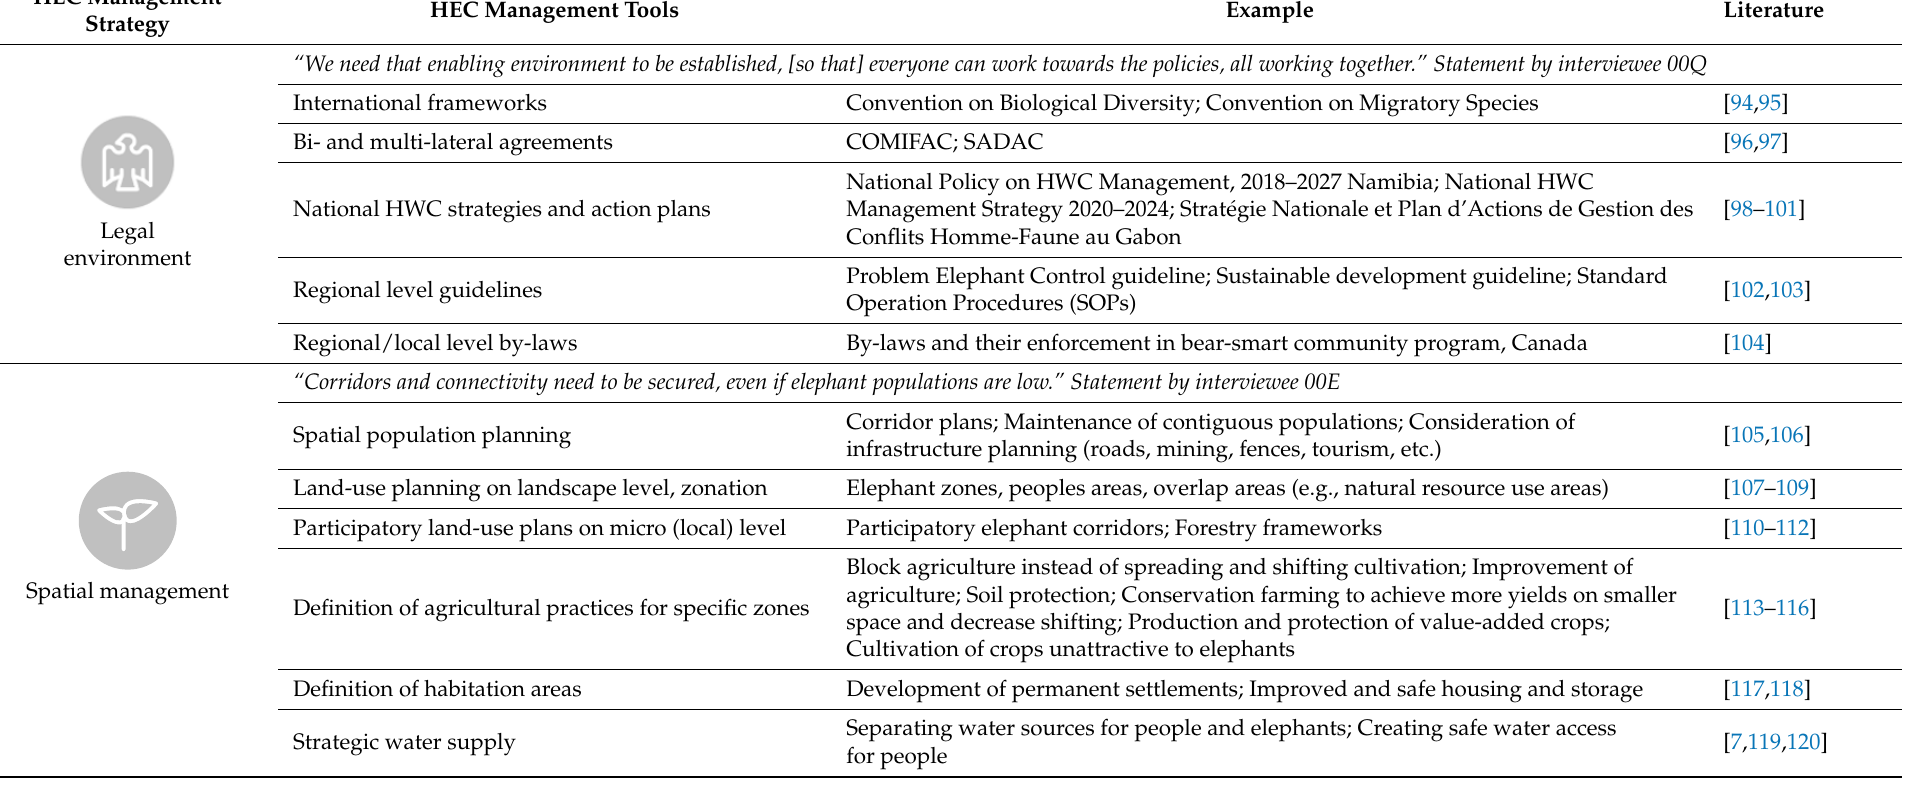
Table 2. Phase 1 results: HEC-management measures and tools grouped in six areas of HEC management operation, supported by quotations from expert interviews.